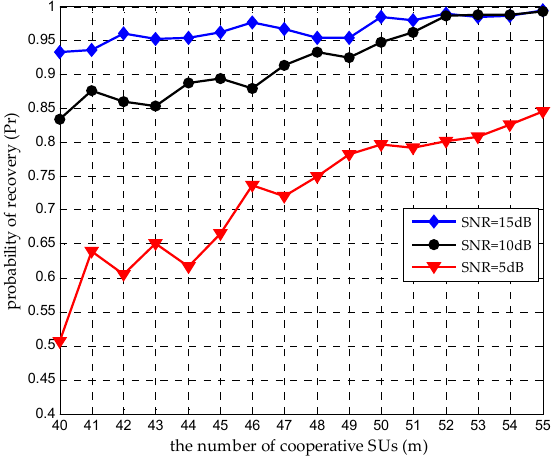
Figure 7. The relation between m and P r under different SNR levels when N = 6 and ε = 0.8. Figure7. The relation between m and Figure7. The relation between m and